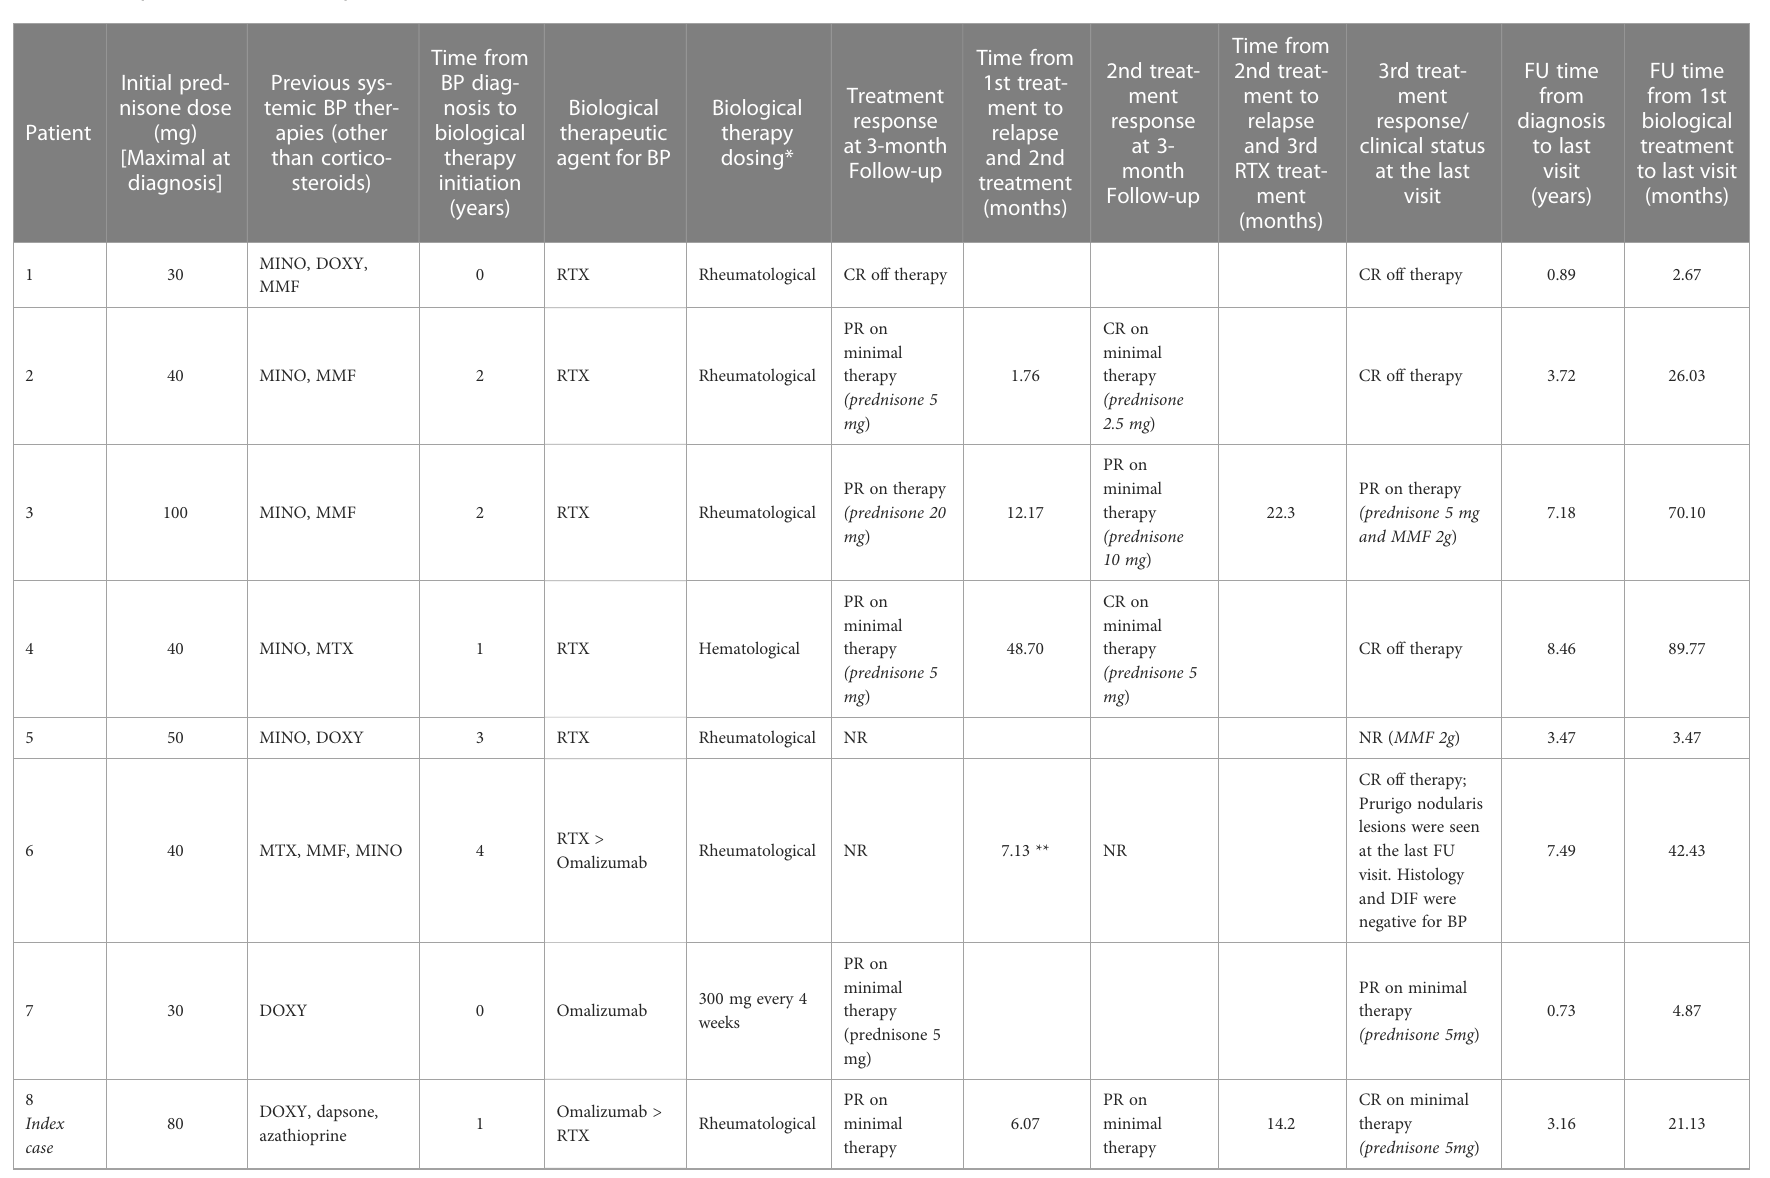
TABLE 2 Therapeutic characteristics of